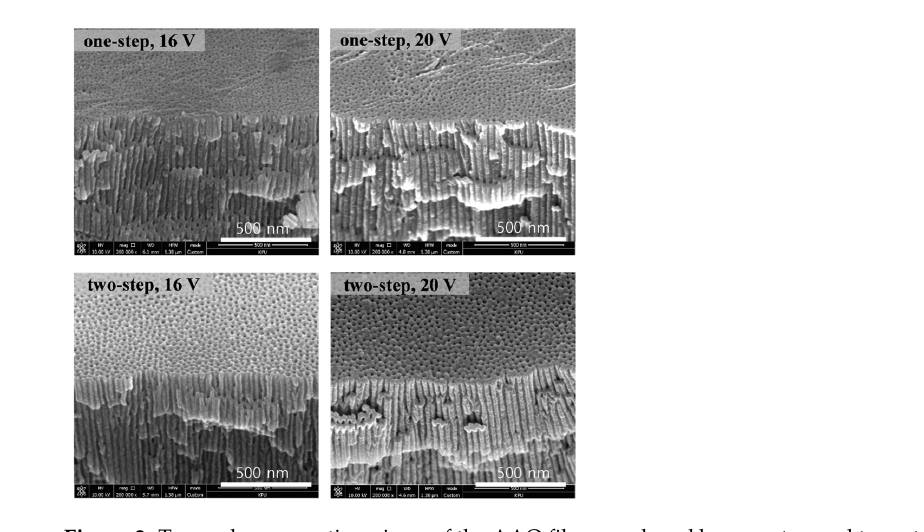
Figure 3. Top and cross-section views of the AAO films produced by one-step and two-step anodizing at 16 and 20 V.